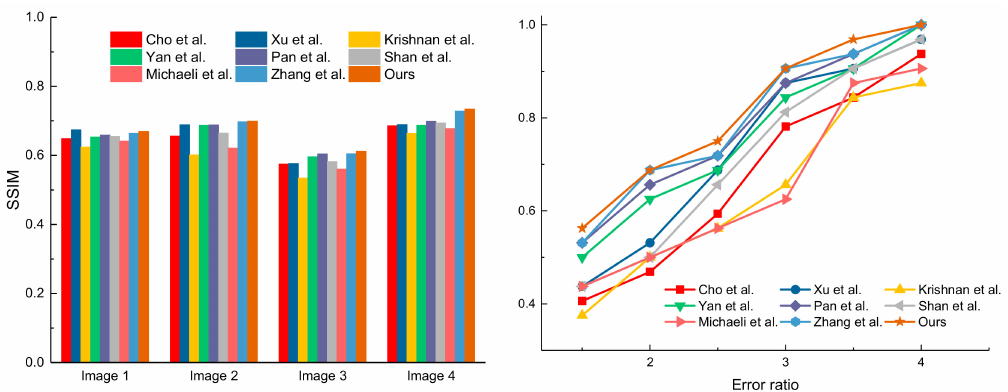
Figure 13. Image deblurring performance of living standing trees.